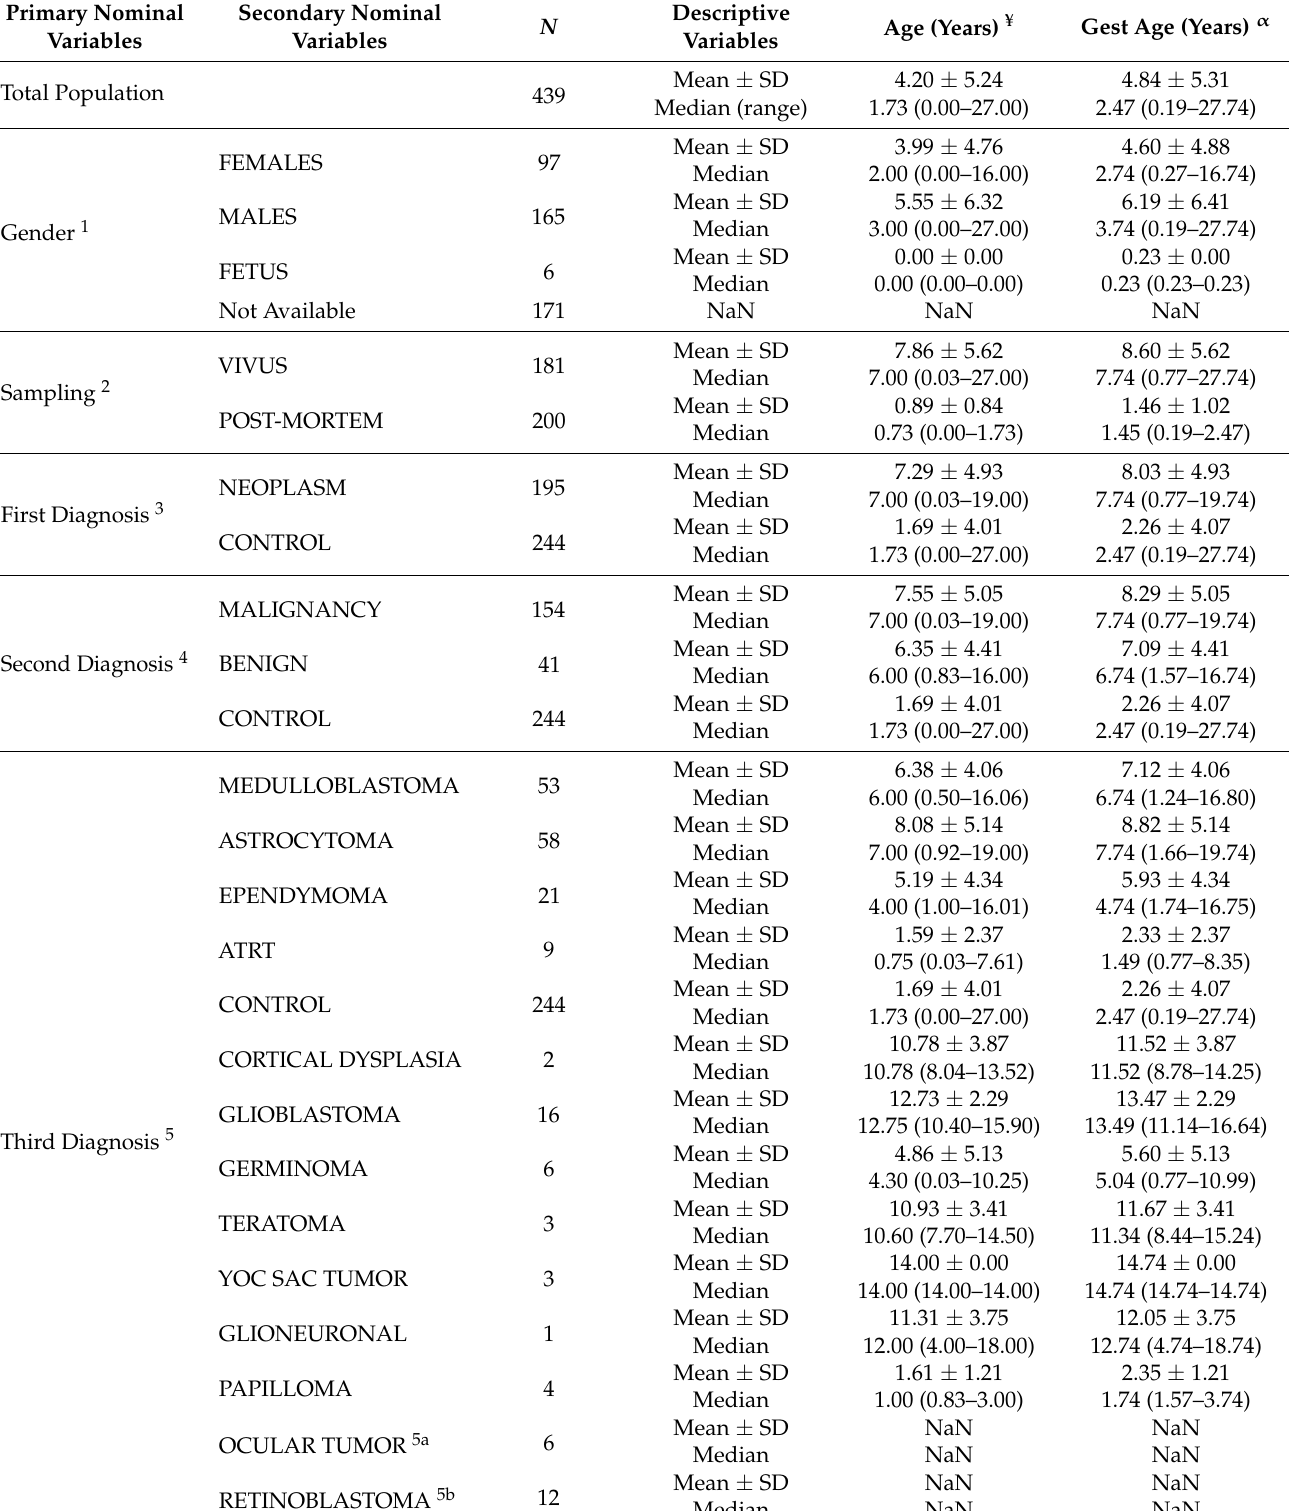
Table 2. The sample cohort that was used in the present